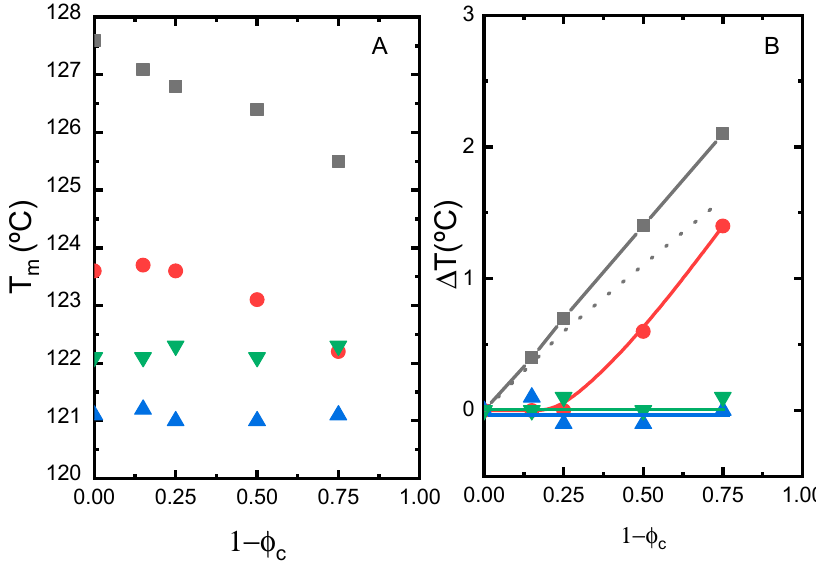
Figure 6. ( A ) Compositional dependence of the melting temperature of the single crystals embedded in EVA matrix. ( B ) Melting temperature depression of the mixtures studied: PE0.0 (squares), PE0.3 (circles), PE0.5 (down triangles) and PE_ZN (up triangles). The dotted line indicates the behaviour of HDPE single crystals embedded in LDPE from the literature [29].